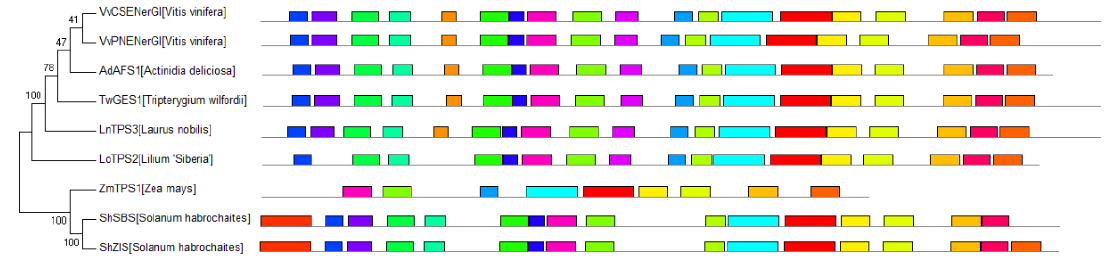
Figure 4. The phylogeny of spermatophyte STSs in the TPS-f subfamily. The colored boxes represent different conserved motifs in spermatophyte STSs predicted by MEME online tool (https://meme-suite.org/meme/) in 11 March 2021.